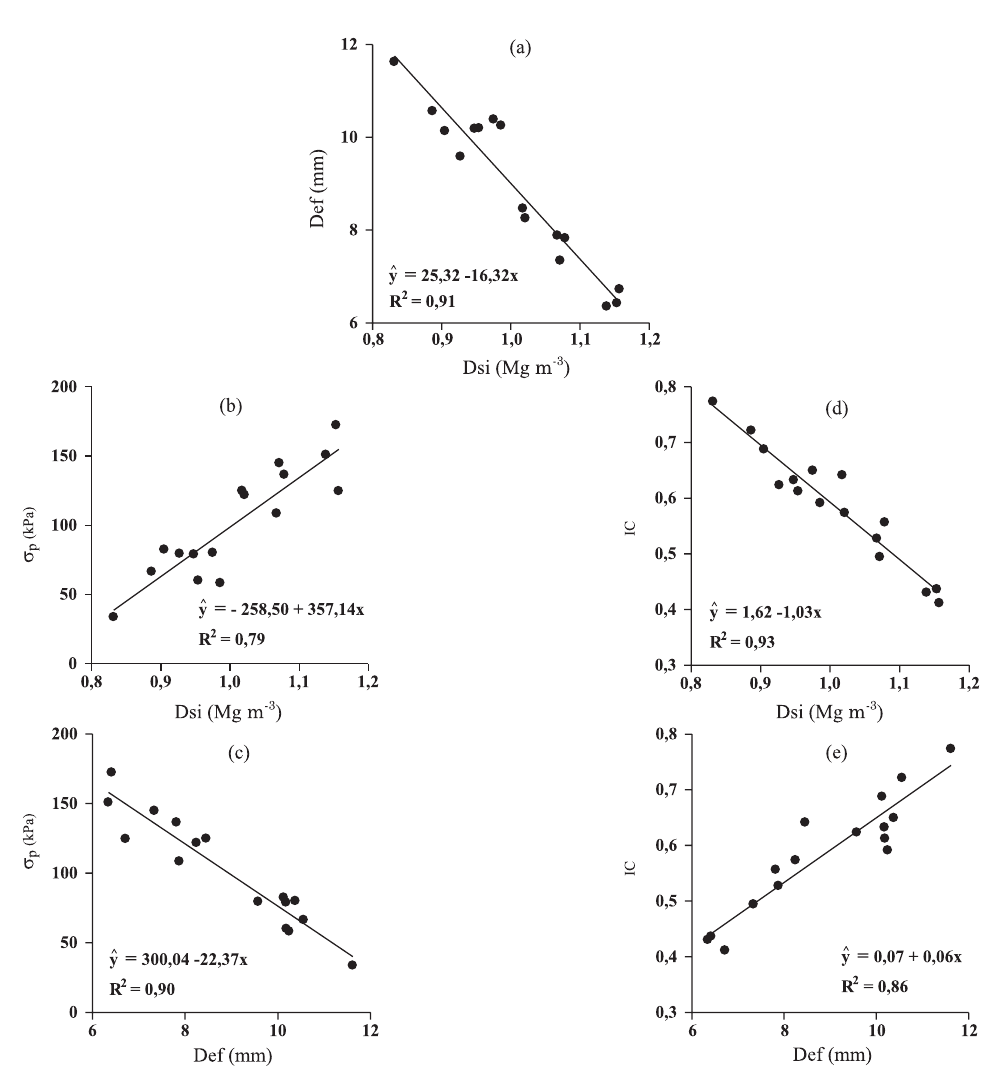
Figura 5. Relações entre a densidade do solo inicial (Dsi) e a deformação do corpo-de-prova ao final do ensaio de compressão uniaxial (Def) (a), a pressão de preconsolidação ( σσσσσ ) (b) e o índice de compressão p (IC) (d), e relações entre a Def e a σσσσσ (c) e o IC (e), considerando o conjunto de amostras (N = 16) de um p Latossolo Vermelho distrófico de textura argilo-arenosa. Todos os valores de R 2 foram significativos (p <